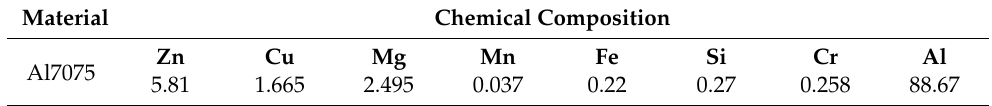
Table 1. Details of chemical composition of